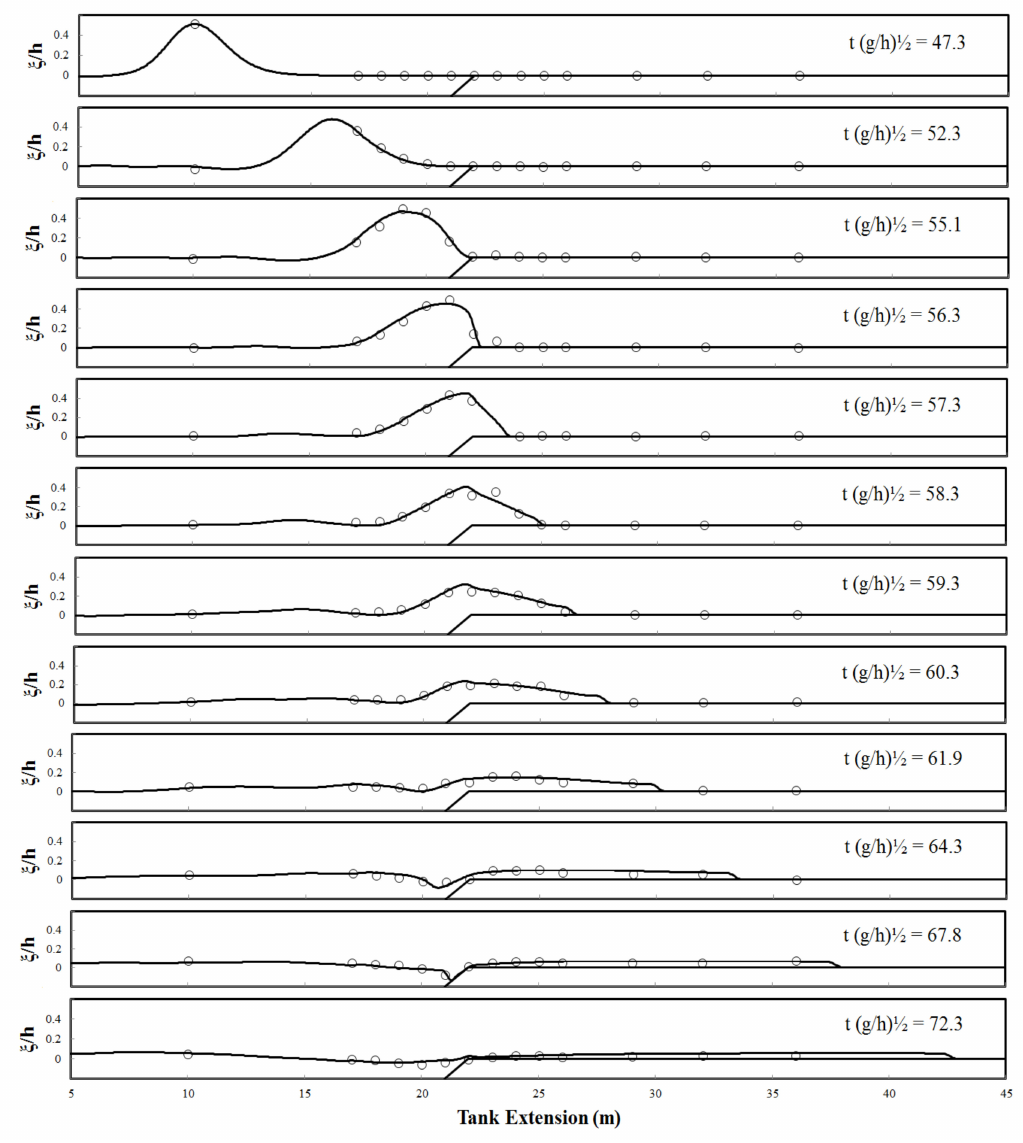
Figure 6. Comparison of simulated and measured surface profiles of a solitary wave over a fringing reef. Experimental data (circles), numerical results (solid lines).